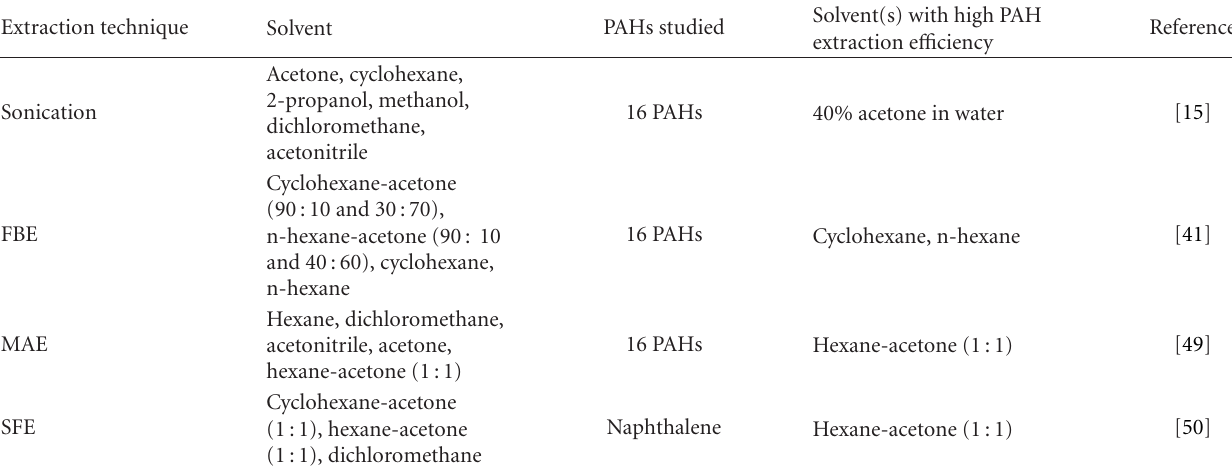
Table 2: Bibliographic compilation of solvents used in the extraction of